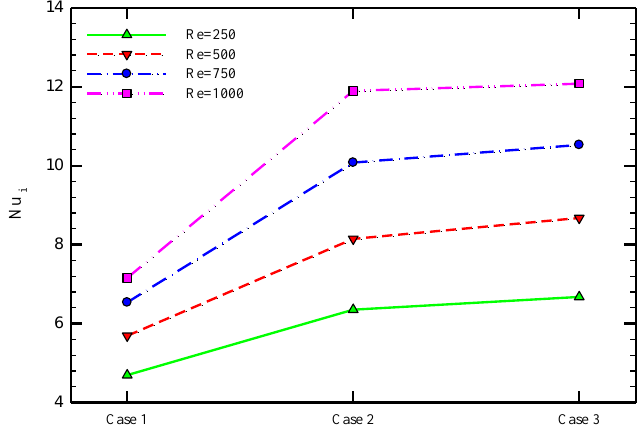
Figure 7. Average Nusselt number for PHE, Co-STT, and Counter-STT at various Reynolds numbers.